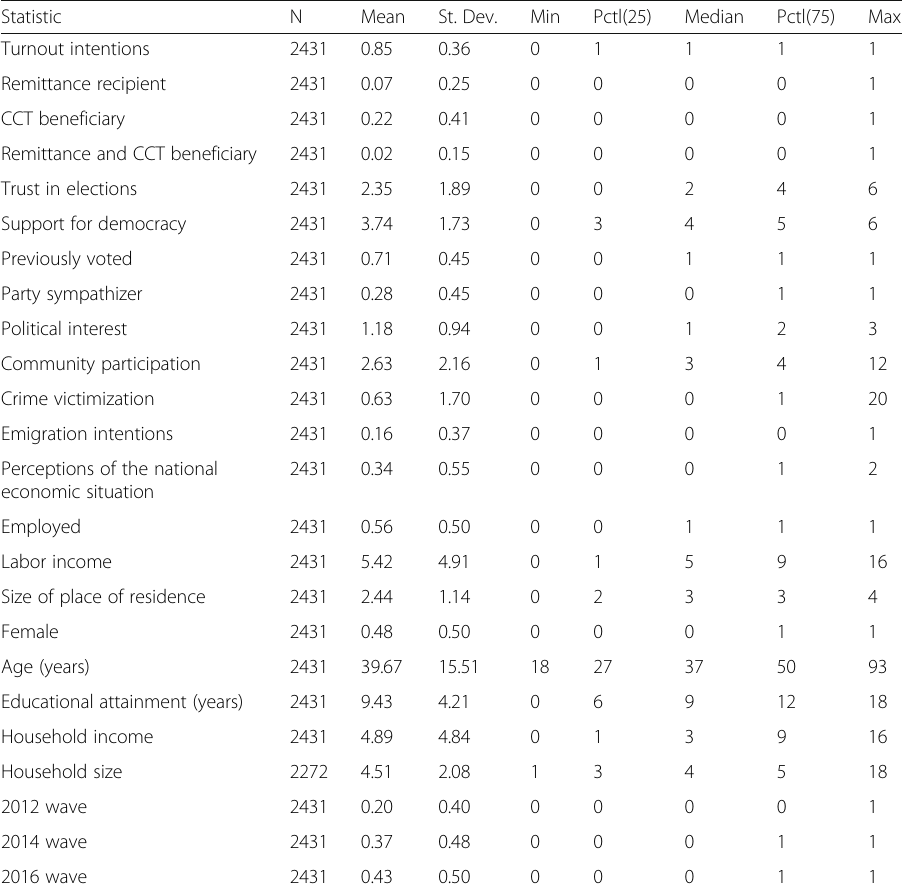
Table 1 Descriptive Statistics. Americas Barometer 2012 –